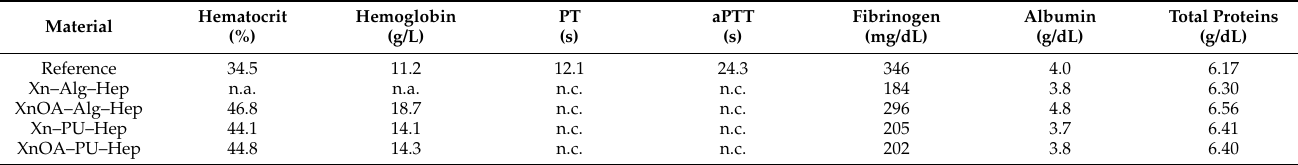
Table 4. Preanalytical blood parameters for the characterization of antithrombotic